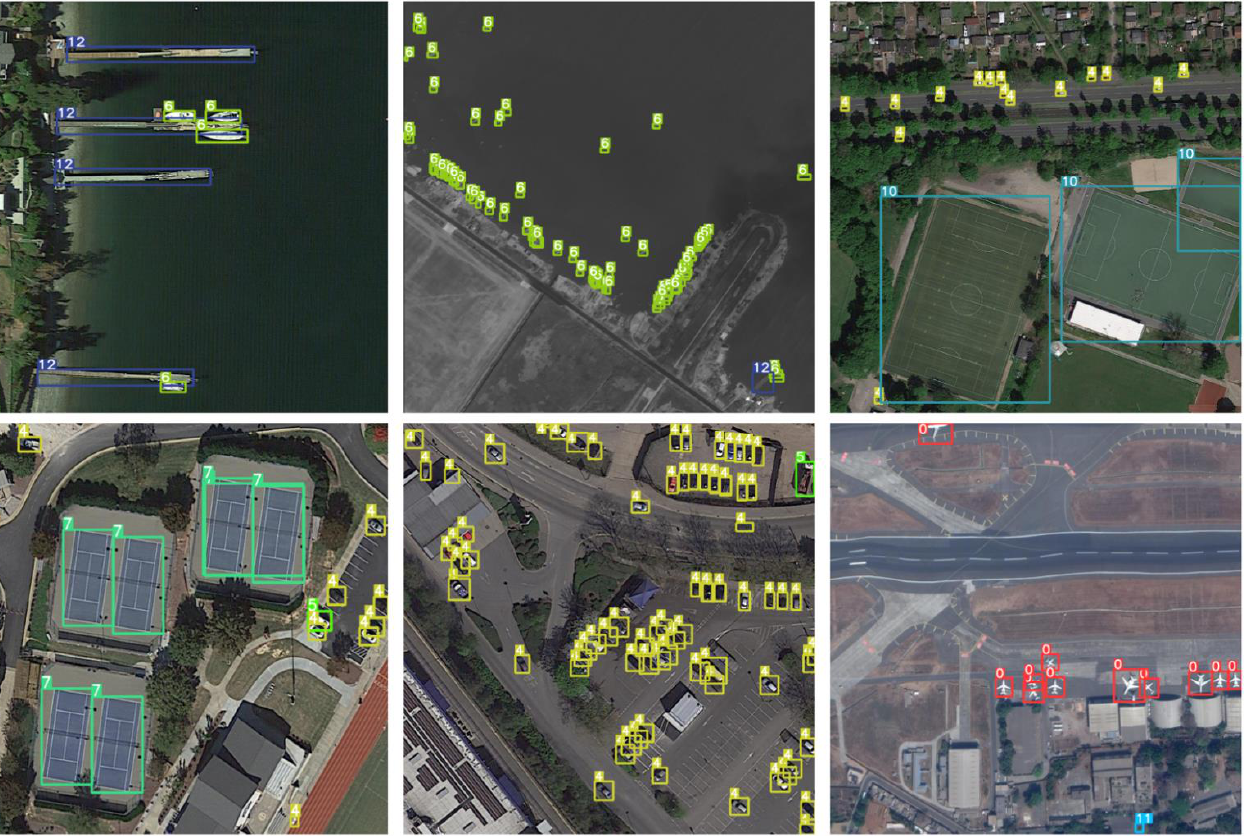
Figure 6. Some visualization results from our SPH-YOLOv5 on the DOTA dataset. The detected boxes are shown with different colors according to different classes. Numbers 0–15 represent plane, baseball diamond, bridge, ground track field, small vehicle, large vehicle, ship, tennis court, basketball court, storage tank, soccer ball field, roundabout, harbor, swimming pool, helicopter, and container crane.